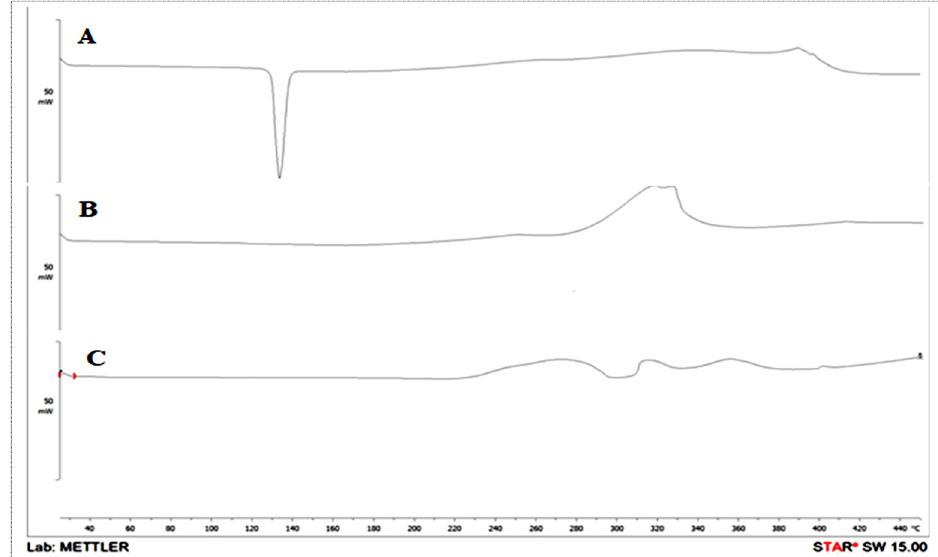
Figure 7. DSC thermogram of ( A ) pure PE, ( B ) Avicel PH-101, and ( C ) S-PE-SNEDDS (SOF3).